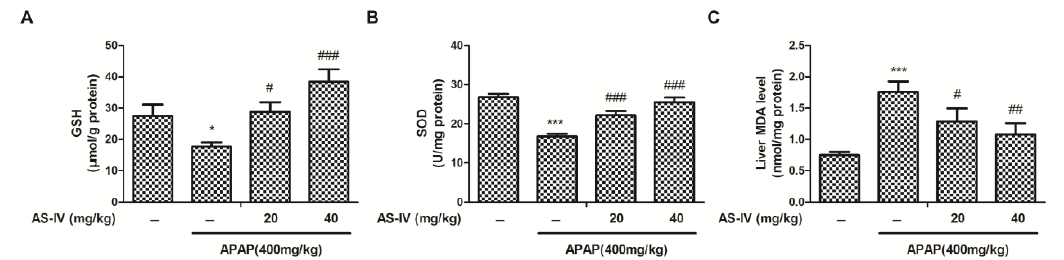
Figure 4. The AS-IV inhibited APAP-induced oxidative stress in liver. After given APAP for 4 h, liver samples were harvested for the GSH amount ( A ), SOD activity ( B ) and MDA content ( C ) evaluation. Data were expressed as means ± SEM ( n = 10). * p < 0.05, *** p < 0.001 compared to vehicle control; # p < 0.05, ## p < 0.01, ### p < 0.001 compared to APAP.